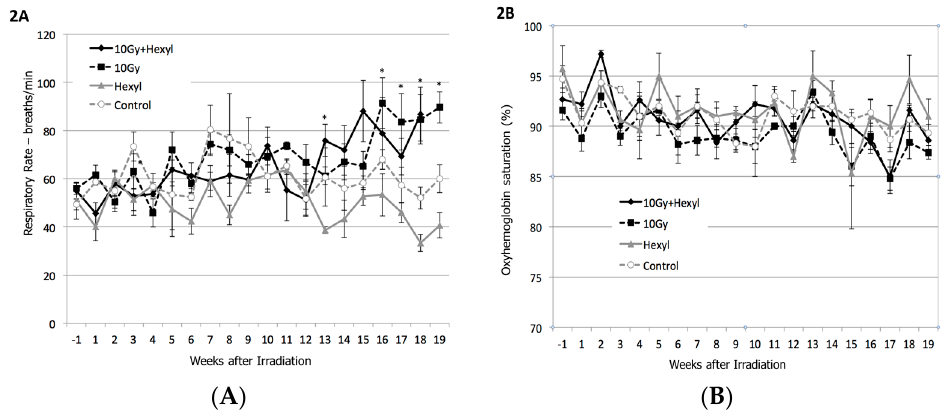
Figure 2. Clinical assessments of pulmonary injury. ( A ) Respiratory rates; irradiated groups differ from non-irradiated animals ( p = 0.008); * indicates individual time point differences at p < 0.05 ( t -test). ( B ) Oxyhemoglobin saturation. Groups do not differ. Error bars are SEM (standard error of the mean). Table 1. Patterns of antibiotic and corticosteroid treatment; median and range.